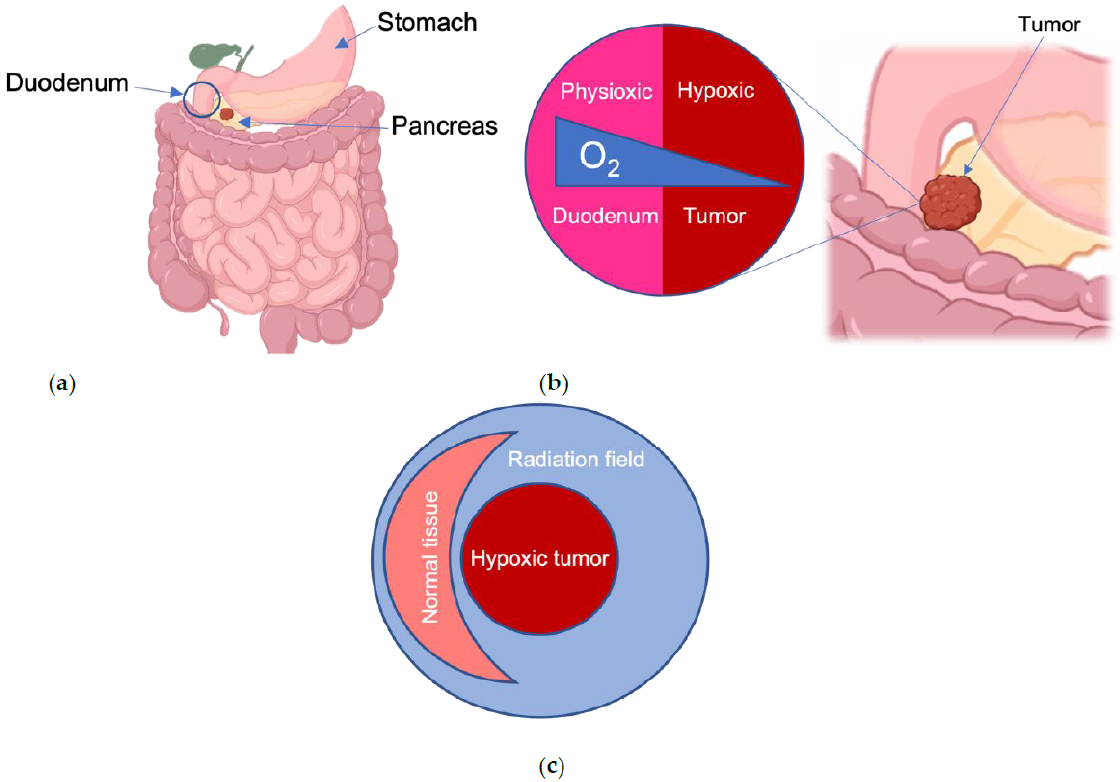
Figure 3. Gastrointestinal organs are susceptible to radiation damage from pancreatic cancer radiotherapy. ( a ) The duodenal portion of the small intestine, the stomach, and other nearby organs are prone to radiation-induced toxicity, especially the rapidly dividing intestinal cells; ( b ) Oxygen concentrations (blue wedge) vary between normal tissues and tumors. Pancreatic tumors near the duodenum are especially hypoxic relative to the physioxic environment of the healthy tissue at risk; ( c ) Nearby normal tissues that would be damaged by CONV-RT would be spared by FLASH-RT, and FLASH-RT would also kill the tumor through the FLASH effect.